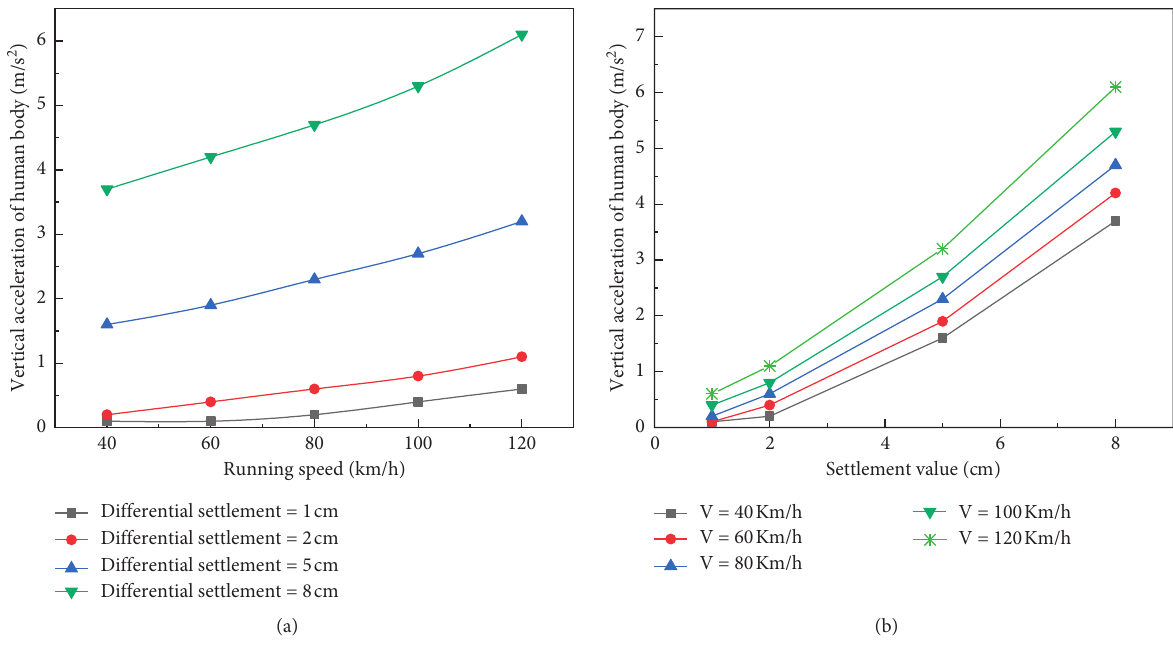
Figure 5: The relationship between the maximum vertical acceleration of the human body with the speed and subsidence. (a) Different running speeds and (b) different subsidence values.